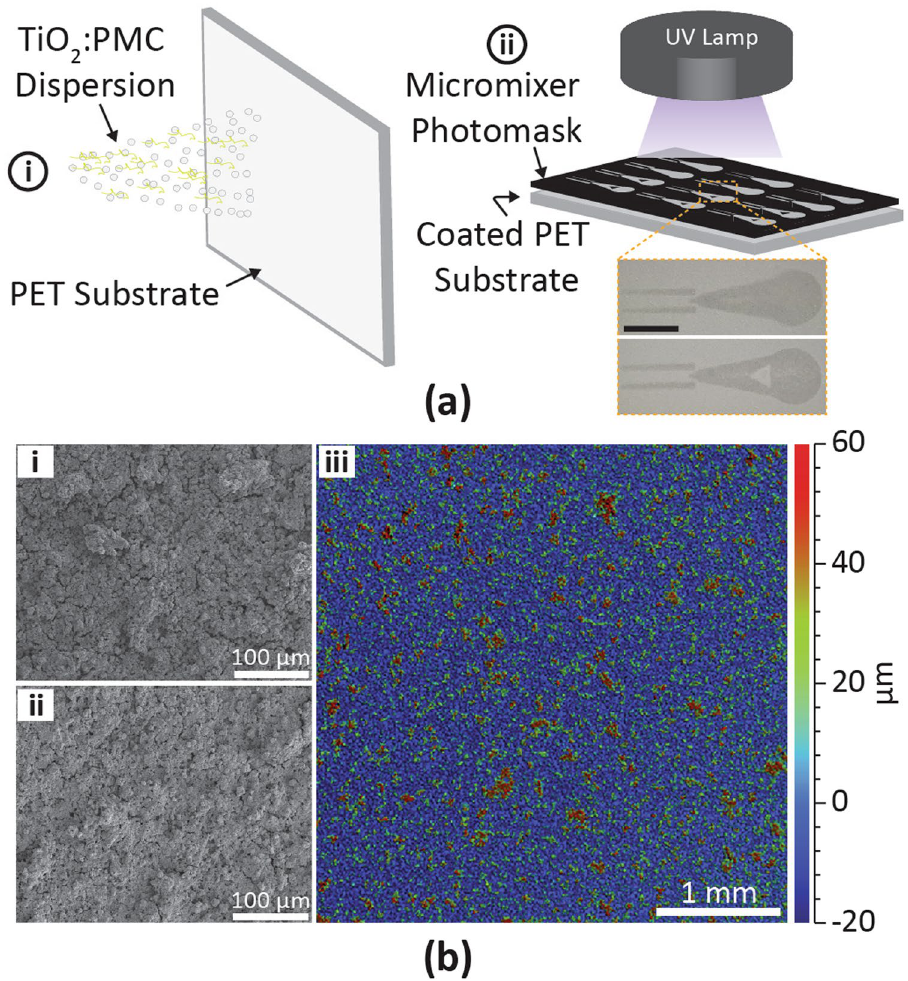
Figure 7. ( a ) Fabrication steps of self-driven surface micromixers (SDSM): (i) TiO 2 :PMC dispersions are sprayed onto the PET substrate. (ii) The superhydrophobic TiO 2 :PMC-coated substrates received partial UV treatment using a photomask. The inset shows top-view images of an actual SDSM: (top) control case with no island, and (bottom) SDSM with triangular, superhydrophobic island. The black scale bar in the top image of the inset denotes 1 cm and applies to both photos. ( b ) Despite the wettability contrast of the superhydrophobic island and superhydrophilic surroundings, the morphology and topography of these two regions are consistent. SEM images of the (i) superhydrophobic, and (ii) superhydrophilic regions of the TiO 2 :PMC surface. (iii) Surface height profile of a domain of a SDSM encompassing a square, superhydrophobic island which cannot be distinguished in this profile map (meaning that UV treatment does not modify the physical texture of the SDSM